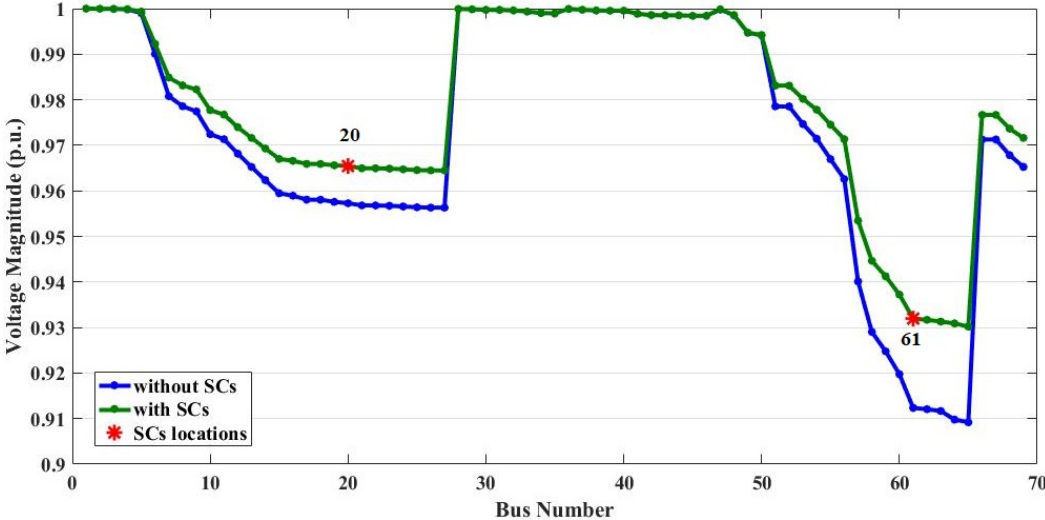
Figure 4. Voltage profile of the 69-bus system considering full-load level using PODESCA.